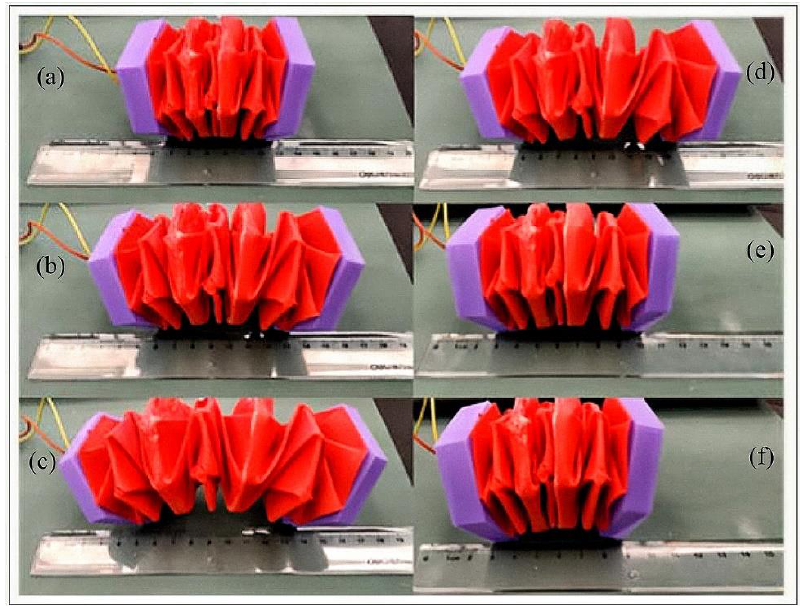
Figure 8. A peristaltic crawling robot with undulatory movements induced by curvilinear deployment [96]. ( a ) Fully compressed state; ( b ) elongating state; ( c ) fully curvilinear deployment; ( d ) starting to compress; ( e ) compressing state; and ( f ) fully compressed state.